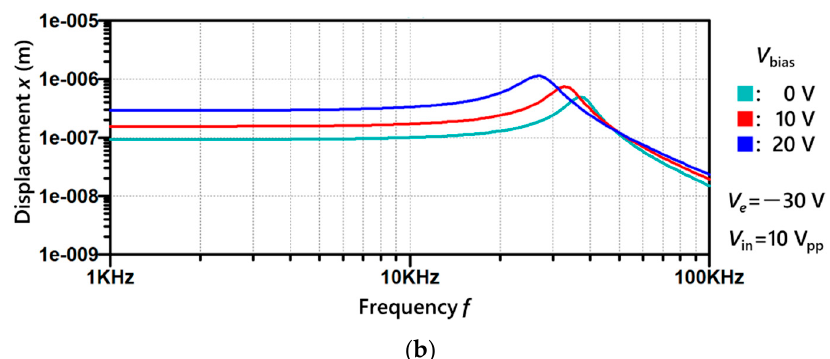
Figure 6. Simulation of dynamic characteristics of gap-closing parallel plate electrode model with electret: ( a ) electret potential V e = 0 V; ( b ) electret potential V e = − 30 V.